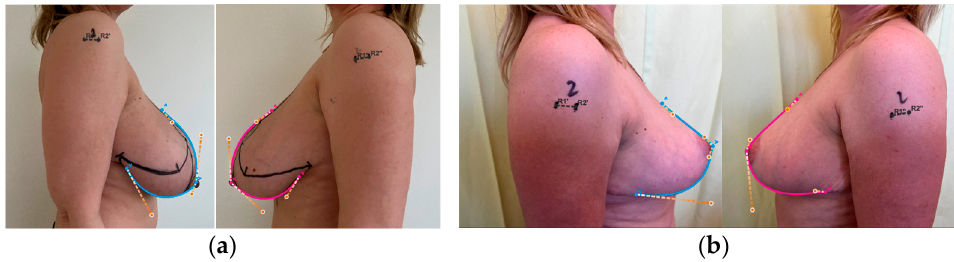
Figure 2. Breast Volume Estimator: ( a ) preoperative volume estimation; ( b ) postoperative volume estimation (6 months after the surgery).